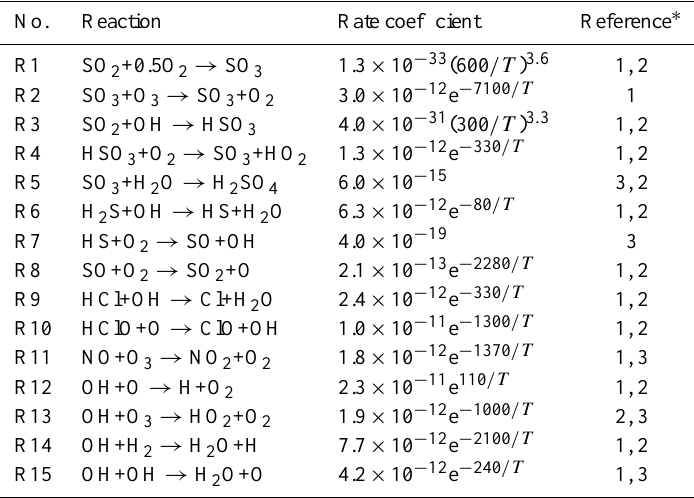
Table A1. Gas-phase reactions and rate coefficients.